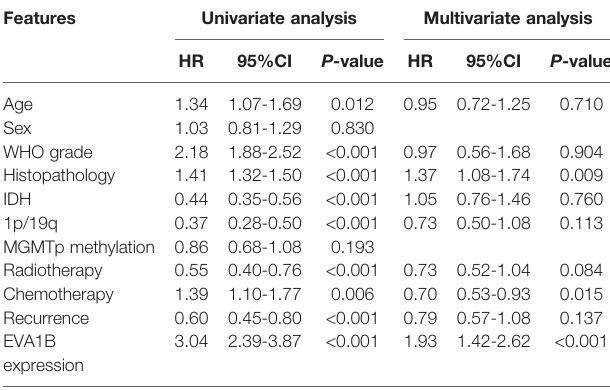
TABLE 2 | Univariate and multivariate Cox-regression analysis of clinicopathological factors affecting the prognosis of patients.